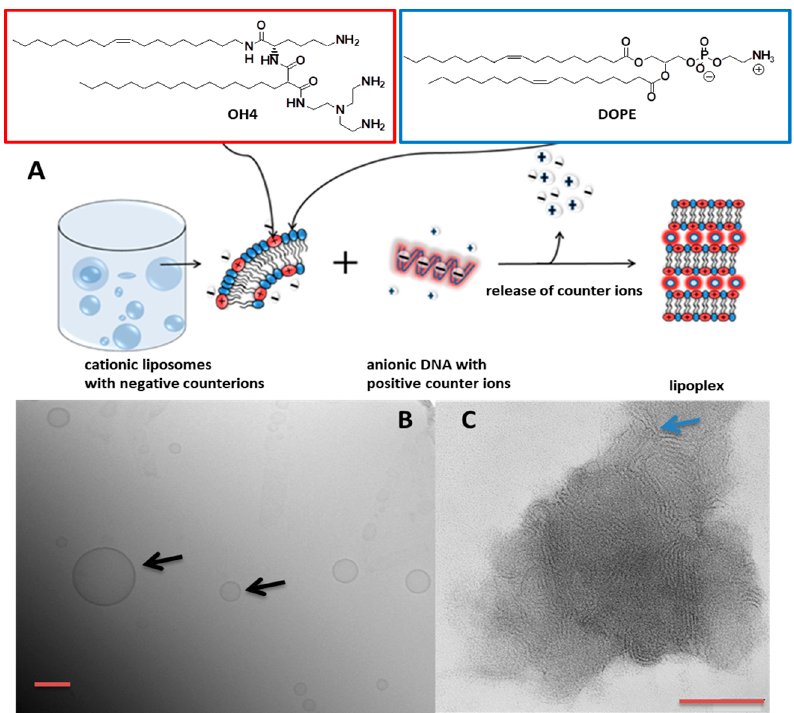
Figure 1. ( A ) Schematic illustration of the process of lipoplex formation. As lipids, the peptide-mimicking cationic lipid OH4 ( N -{6-amino-1-[ N -(9 Z )-octadec-9-enylamino]-1-oxohexan-(2 S )-2-yl- N ′ -{2-[ N , N -bis(2-aminoethyl)amino]ethyl}-2-hexadecylpropandiamide) and the neutral co-lipid DOPE (1,2-dioleoyl- sn -glycero-3-phosphoethanolamine) were used. The scheme describes the complex formation between cationic lipid formulation and DNA. Both structures attract counter-ions which are released after complex formation, resulting in an increase in entropy. This gain of entropy and the electrostatic forces are the driving forces for the lipoplex formation. ( B ) Cryo-TEM micrograph of OH4 / DOPE 1 / 1 (n / n) vesicles. The black arrows indicate liposomes. ( C ) Negative stain TEM of OH4 / DOPE 1 / 1 (n / n) lipoplexes at N / P (ratio of the primary amino functions of the lipids to phosphate of the DNA) 4 complexing 4.7 kb pDNA. The blue arrow indicates the lamellar substructure of a lipoplex. The scale bars correspond to 100 nm.